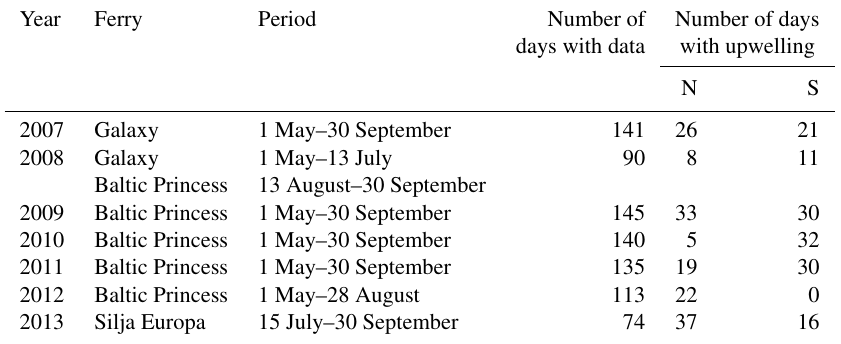
Table 1. Periods of measurements along the Tallinn–Helsinki ferry route in 2007–2013, number of days with measurements and number of days with upwelling events off the northern coast (N) and off the southern coast (S). Year Ferry Period Number of Number of days days with data with upwelling N S 2007